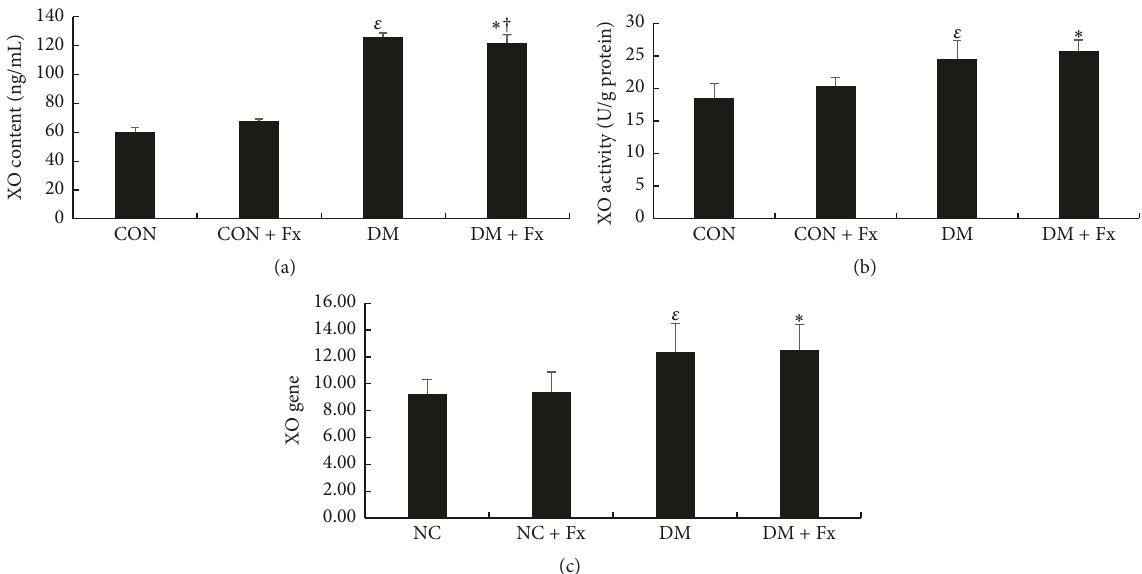
Figure5:Hepaticcontent,activity,andgeneexpressionofxanthineoxidase(XO).HepaticcontentofXO(a)wasexpressedasitsconcentration in the supernatant of liver extract. Hepatic XO activity (b) was calculated according to the XO protein ratio and expressed as U/g protein. Relative gene expression (c) was determined by RT-PCR and shown in the graph as the amounts of initial template. Data are expressed as mean ± SD. 𝜀 푃 < 0.05 when the DM group was compared with CON or CON + Fx group, ∗ 푃 < 0.05 when DM + Fx group was compared with CON or CON + Fx, and † when compared with DM group,